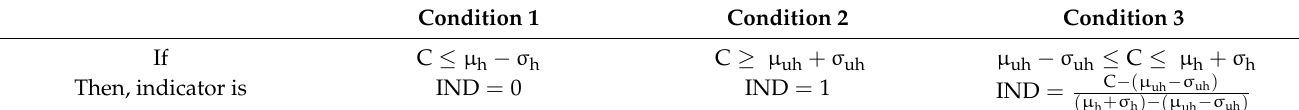
Table 7. Classification rules specified for the new incoming candidate into the variation interval.